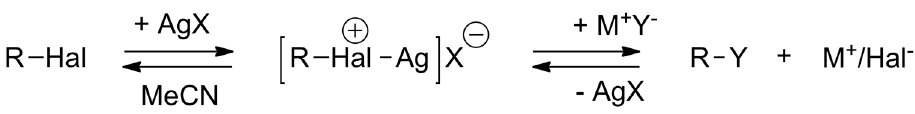
Scheme 37. Use of Ag + salts in the catalysis of S N 2 reactions.